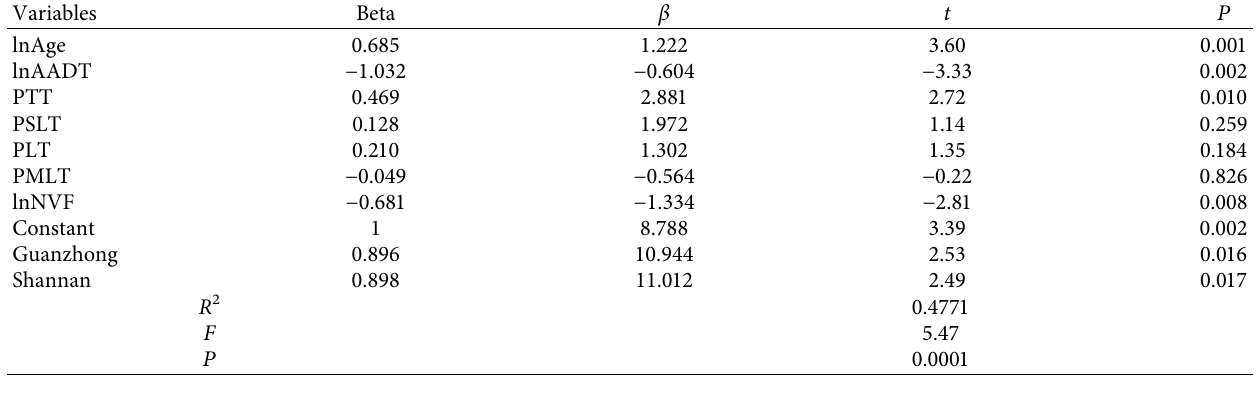
Table 6: Fixed-efect regression model.